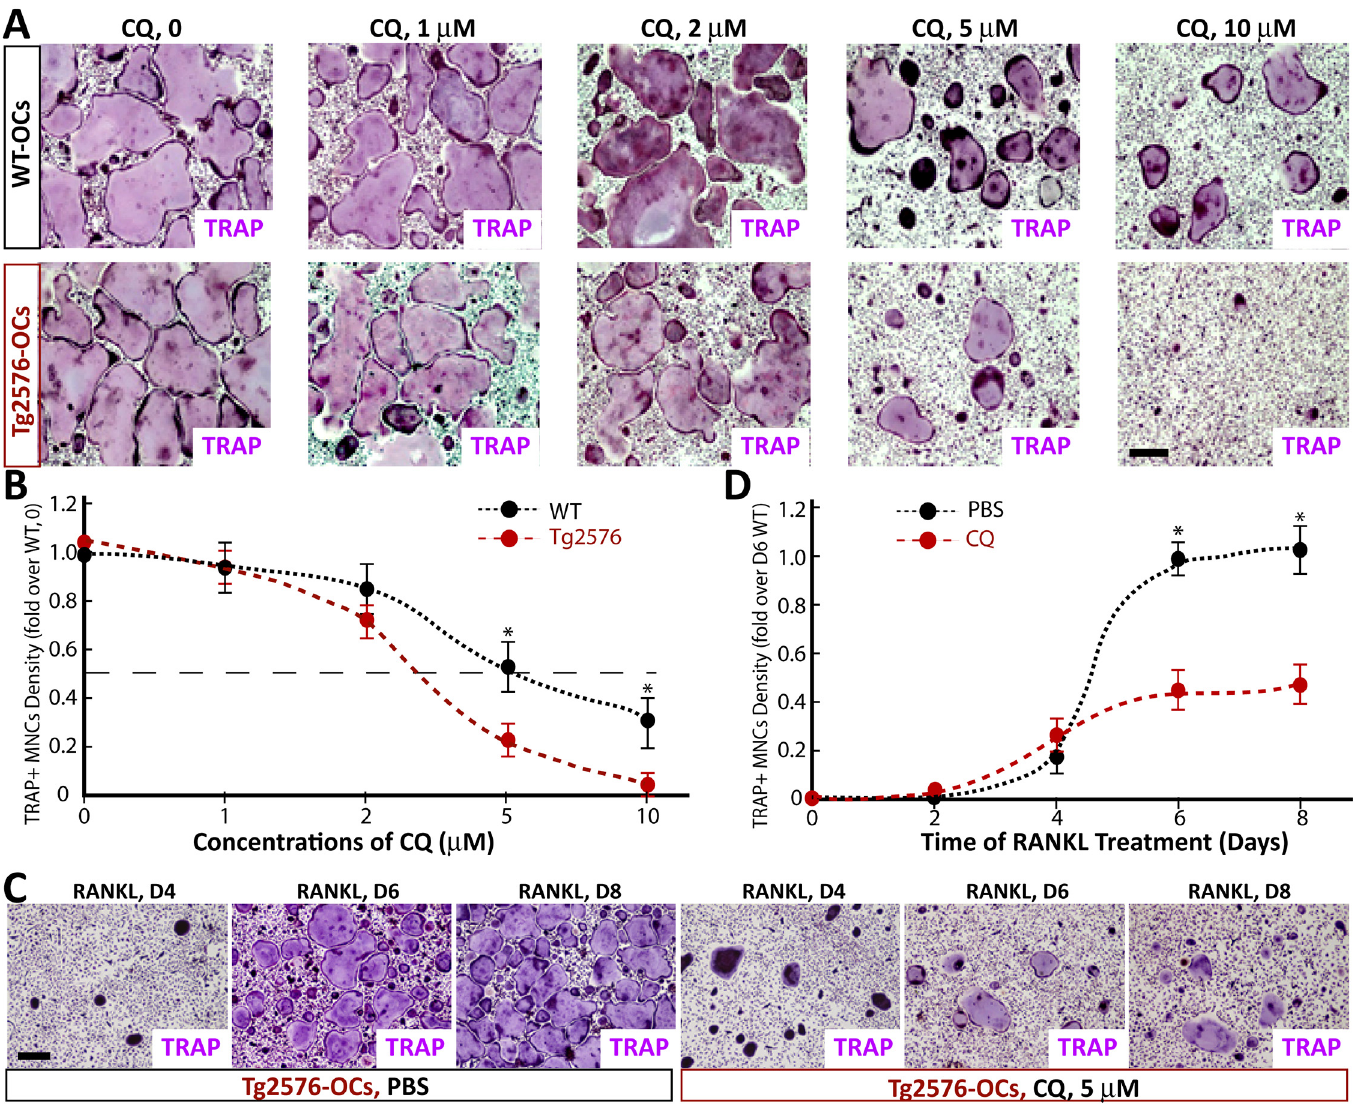
Fig 3. CQ suppression of in vitro OC genesis in a dose- and time-dependent manners. (A-B) BMMs from WT and Tg2576 mice were induced for OC differentiation in the presence or absence of various concentrations (1, 2, 5, and 10 microM) of CQ. At day 5 of RANKL induction, cells were stained for TRAP. A, Representative images. B, quantitative analyses. The effective concentrations of CQ for 50% inhibition of OC genesis is ~5 microM and ~2.25 microM in WT- and Tg2576-BMMs, respectively. (C-D) BMMs from WT and Tg2576 mice were induced for OC differentiation in the presence of CQ (5 microM). Cells were cultured for different days (day 6-D6, D8) and stained with TRAP. C, Representative images. D, Quantitative analyses. The values of mean ± SD from 3 separate cultures were shown. * , p < 0.05, significant